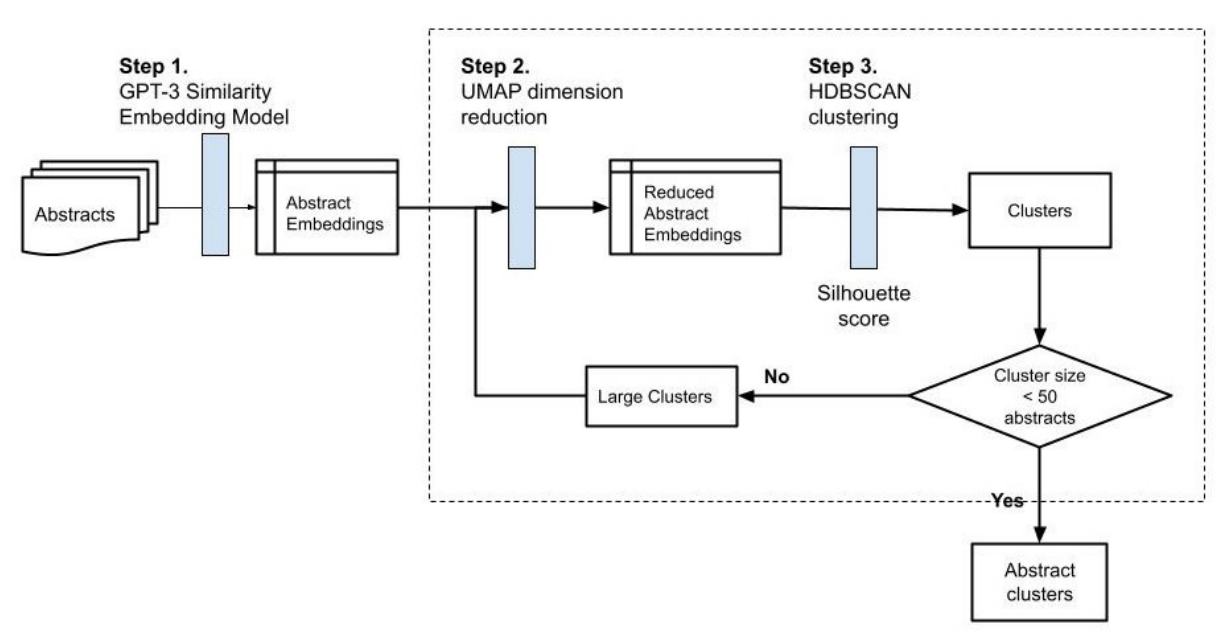
Figure 2. The iterative clustering procedure.